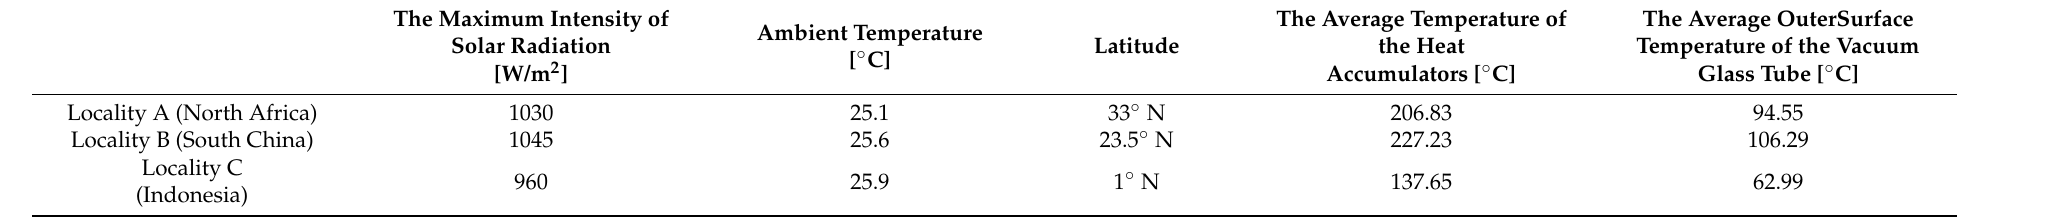
Table 2. Average temperature of the heat accumulators and outer surface of the vacuum glass tube at